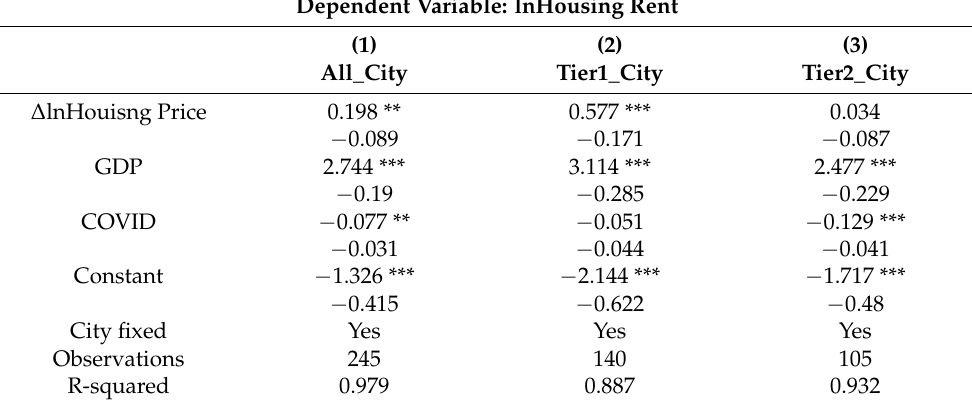
Table 9. Housing rent long-term